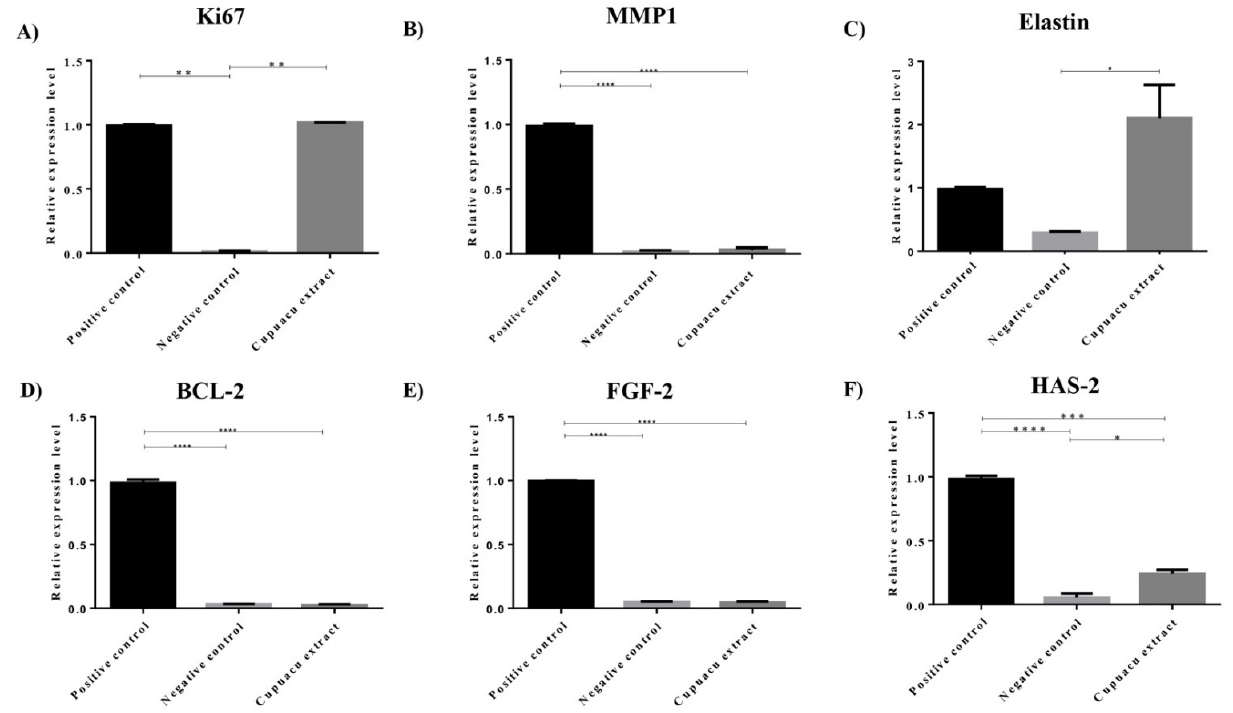
Figure 3. Effect of the Cupuaçu seed extract on the mRNA levels of ( A ) Ki-67, ( B ) MMP-1 (matrix metalloproteinase-1), ( C ) Elastin, ( D ) BCL-2, ( E ) FGF-2 (fibroblast growth factor-2), and ( F ) HAS-2 (hyaluronic acid synthase-2) genes. Positive control represents cells maintained in basal medium with FBS, and negative control maintained in the absence of FBS. Statistical differences were verified by two-way ANOVA test and Tukey post hoc test. * p < 0.05; ** p < 0.01; *** p < 0.001, **** p < 0.0001.